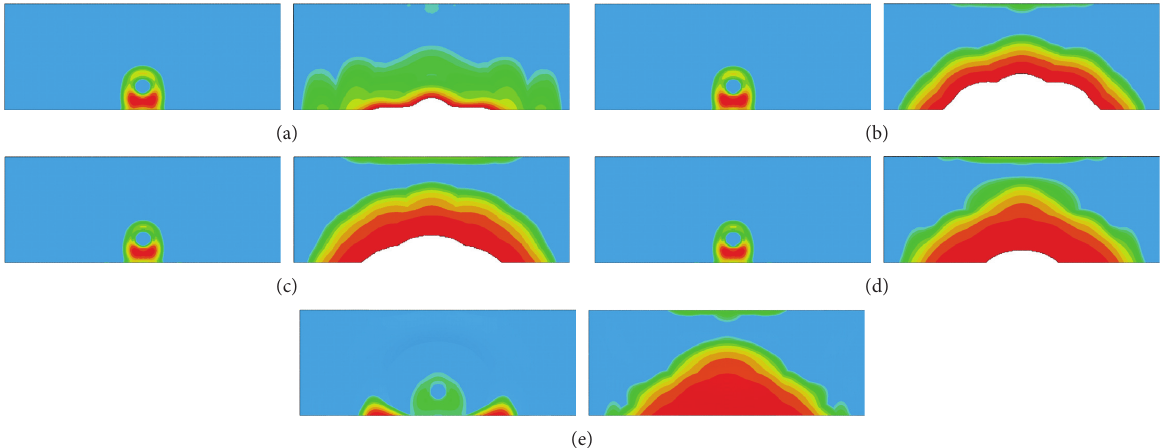
Figure 23: Distribution of the interfacial damage when the maximum vertical deformation is achieved for different E are for the compression stage and the rebound stage, respectively. (a) E n � 0.2MPa/mm. (b) E n � 0.5MPa/mm. (c) E n � 1.0MPa/mm. (d)